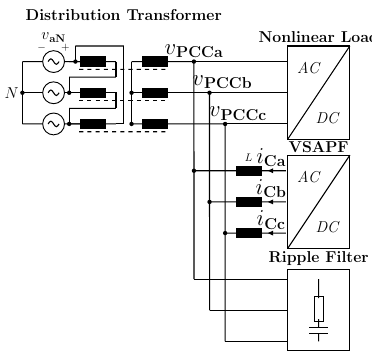
Figure 1. Shunt active power filter based on voltage detection (VSAPF) connected to a three phase distribution network. A ripple filter (RC combination) is installed alongside of the SAPF in order to avoid switching noise penetration into the grid. PCC: Point of Common Coupling [1].